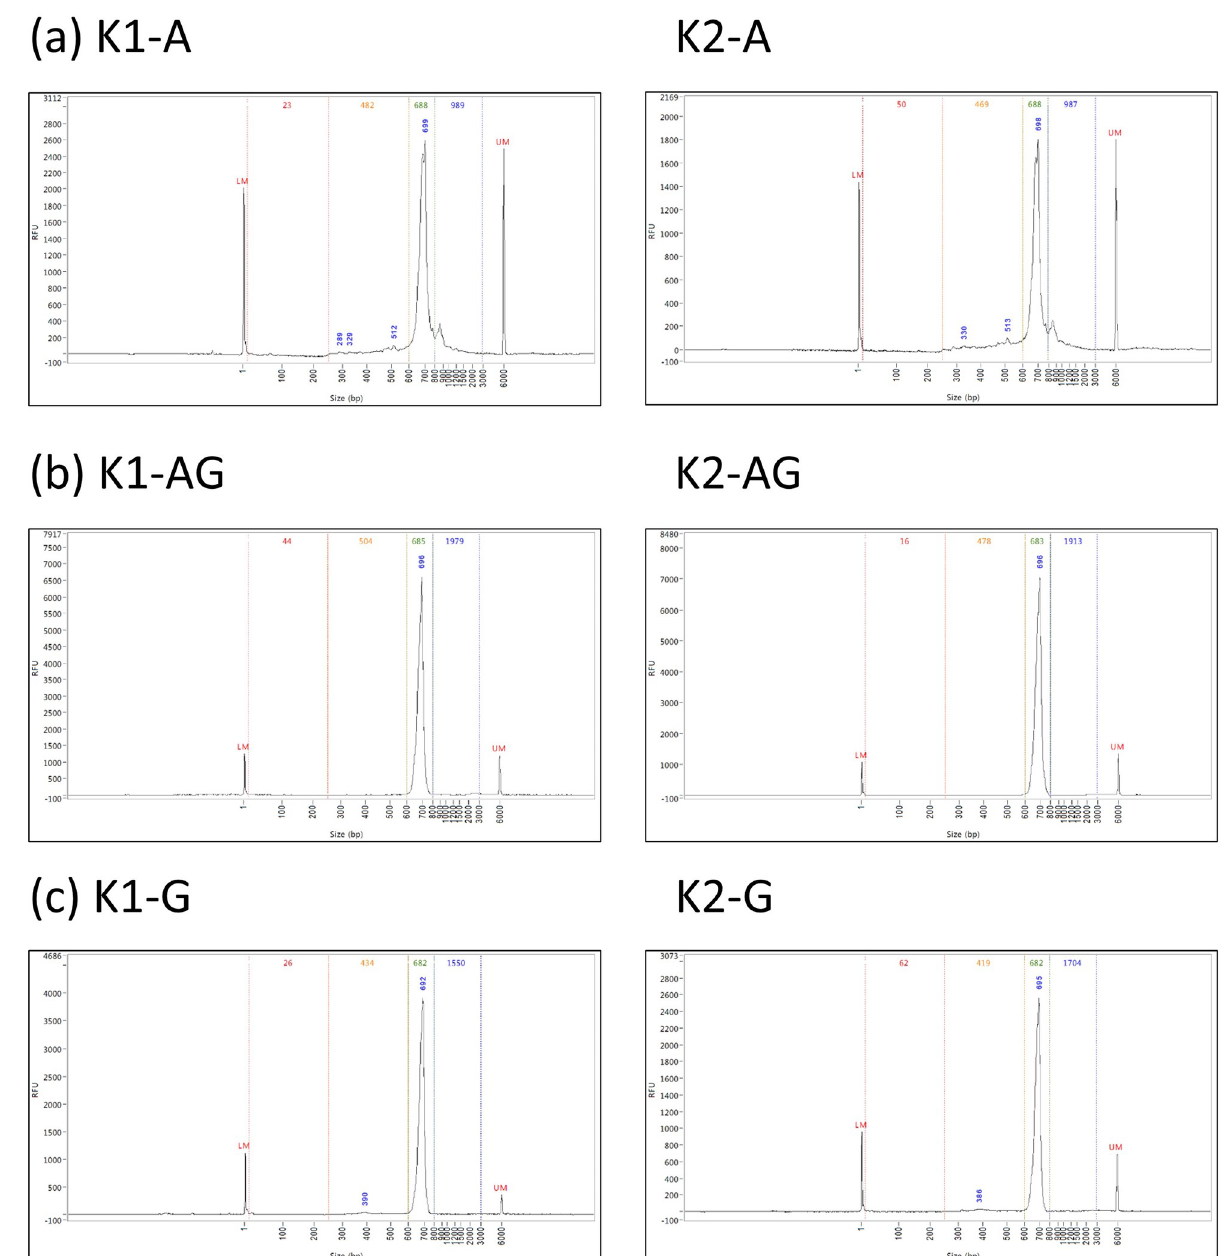
Fig 3. Fragment length distributions of 5’-RACE libraries constructed using protocol (a) A, (b) AG, and (c) G from blood sample of individual K with two technical repeats (K1 and K2) for each protocol.